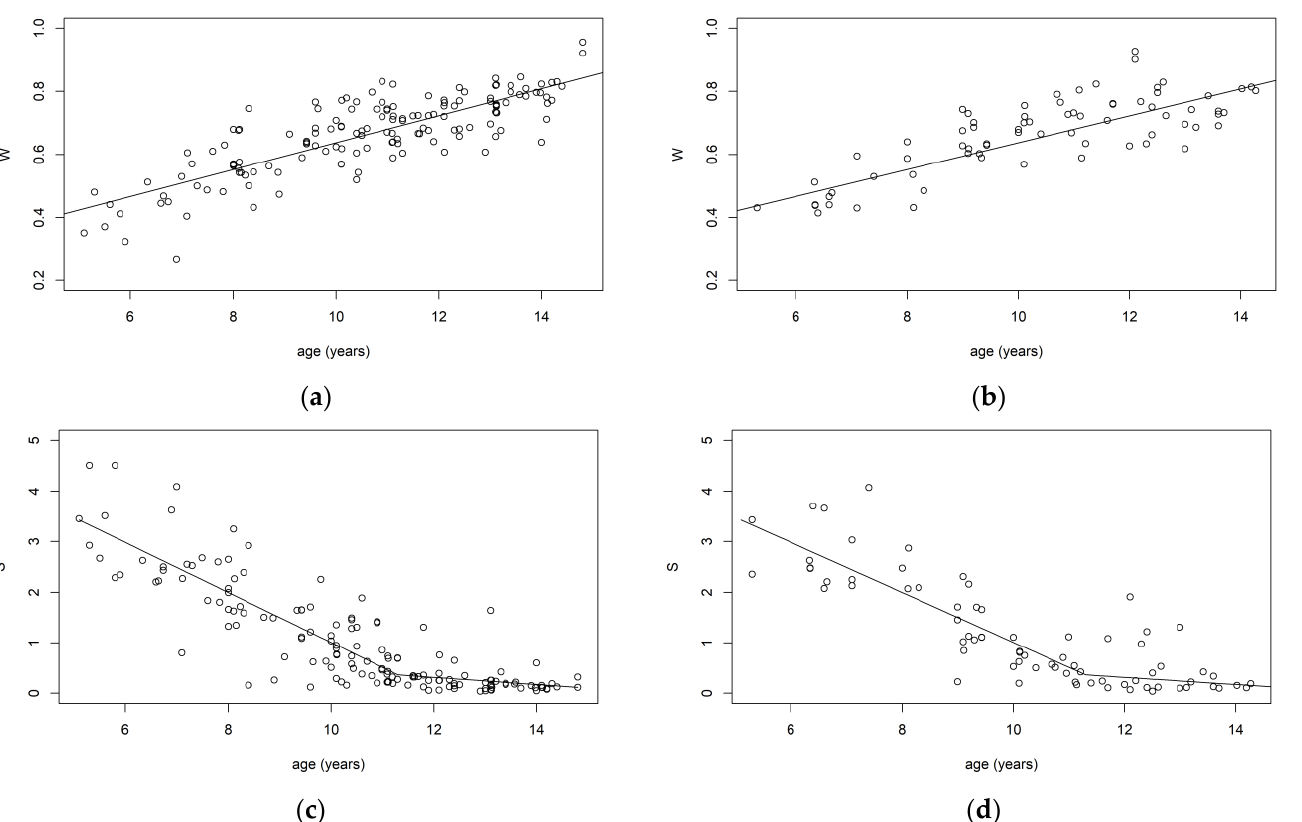
Figure 1. Relationship between age and the maturity indices, S and W , in the training and validation samples. ( a ) Relationship between age and W in training sample. ( b ) Relationship between age and W in validation sample. ( c ) Relationship between age and S in training sample. ( d ) Relationship between age and S in validation sample.